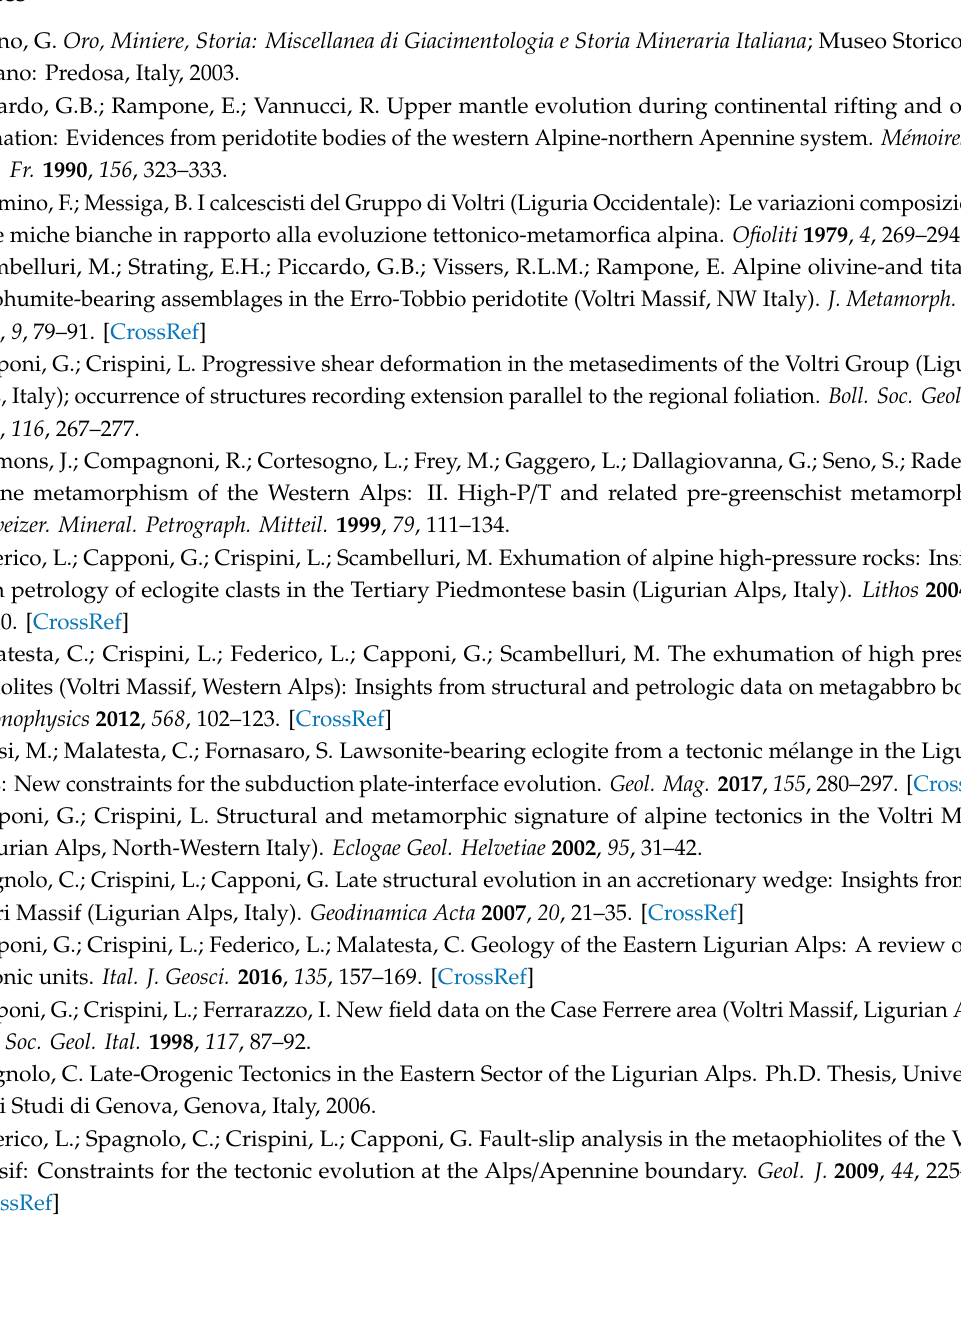
Figure S1: Geological map of a treasure chest of geodiversity: the Lavagnina Lakes area (Alessandria,